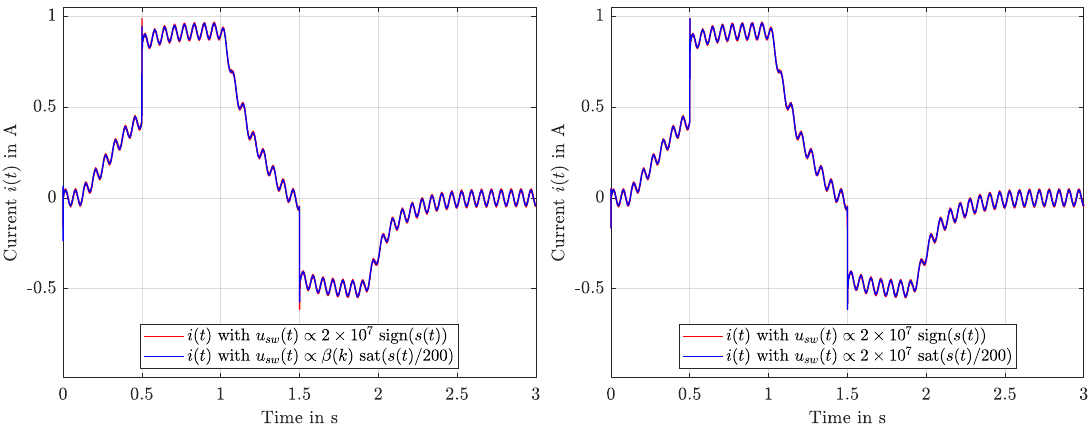
Figure 10. Simulated currents i for all the variants.